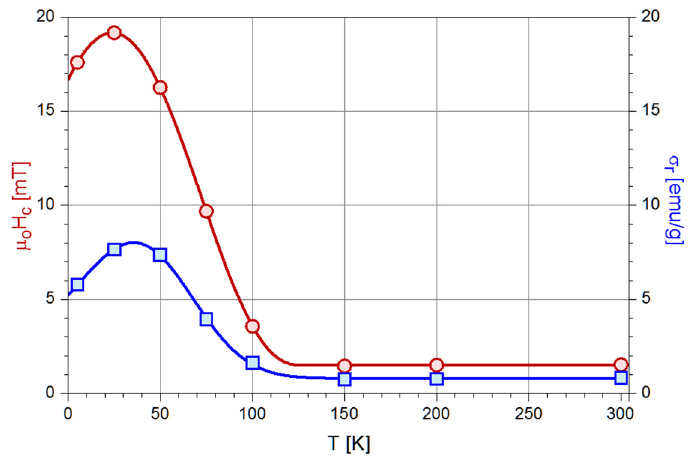
Figure 6. Thermal evolution between 5 K and 300 K of the DC coercive field (µ o H c ) and the mag- netite microcrystals` remanent magnetization ( σ r ).